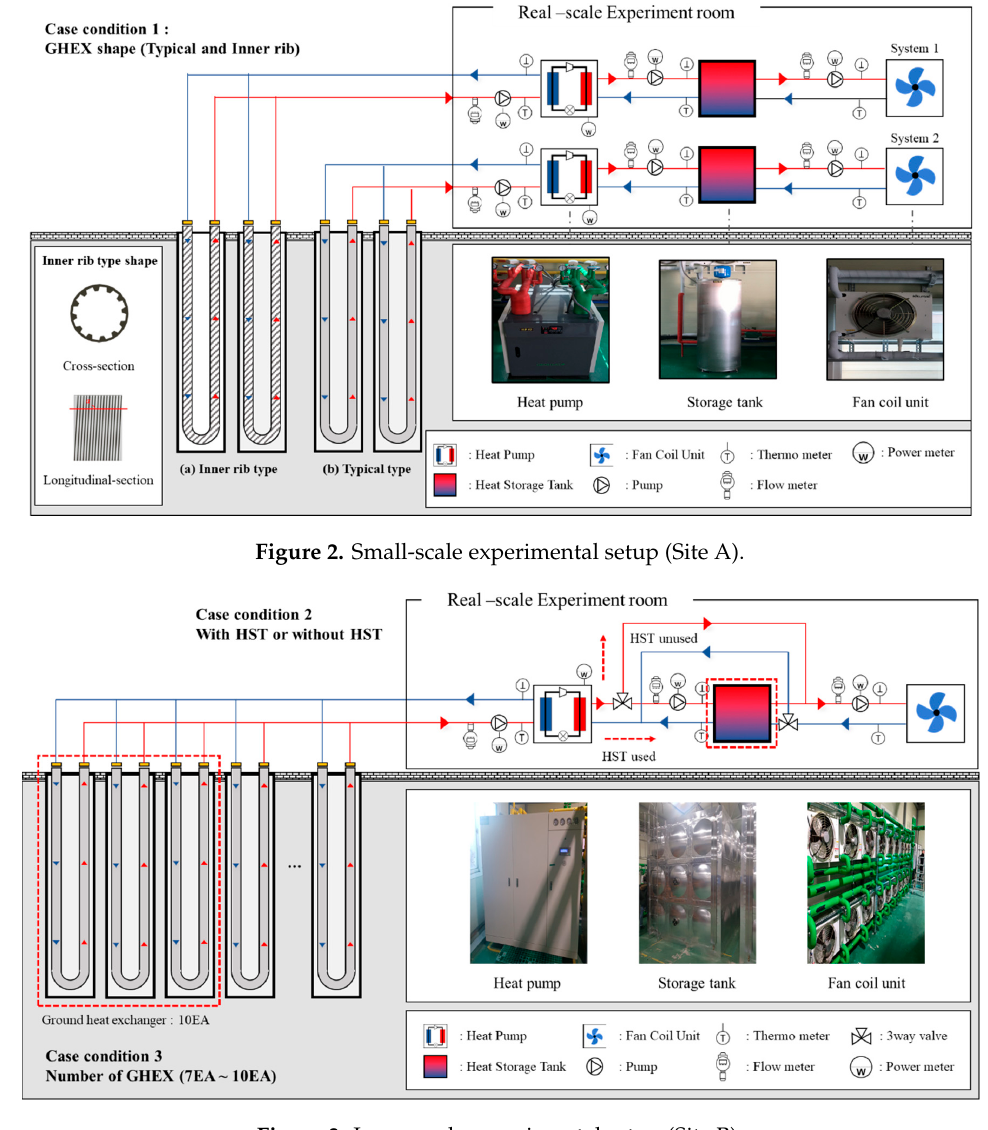
Figure 3. Large-scale experimental setup (Site B). Table 1. Experimental conditions. HDPE: high-density polyethylene.